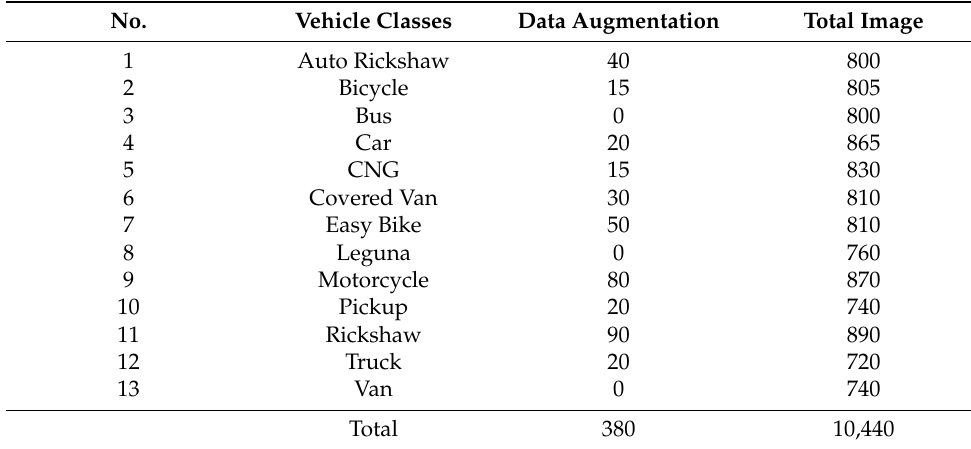
Table 1. Data description of Deshi-BD vehicle dataset.